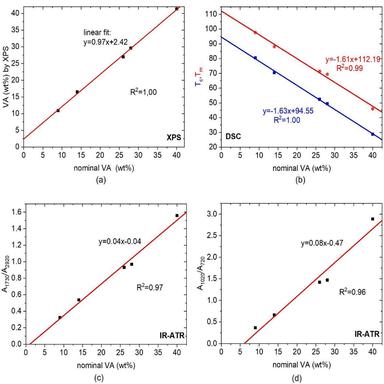
Relationships of (a) the VA content deduced from XPS spectra, (b) crystallization and melting peak temperature (Tc, Tm) and (c), (d) IR-ATR absorption ratios with the nominal VA content.